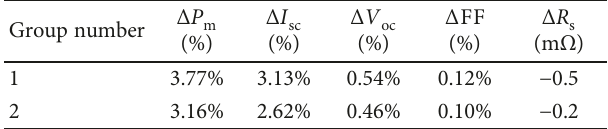
Figure 15: The appearance (a) and EL image (b) of a module made with conductive belts and four half cells after aging tests. Table 2: The average degradations of the module electric performance after aging tests: group 1, conventional four-busbar modules; group 2, modules made with conductive